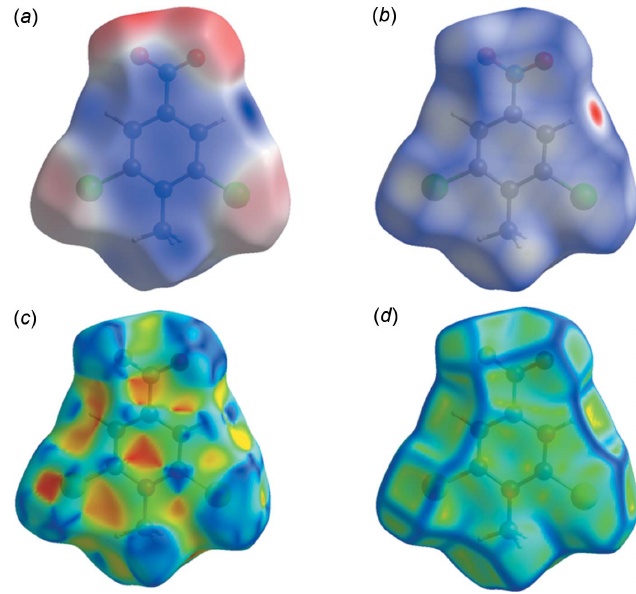
Figure 8 A view of the Hirshfeld surface of DINT mapped over d norm , with interactions shown as dashed lines.